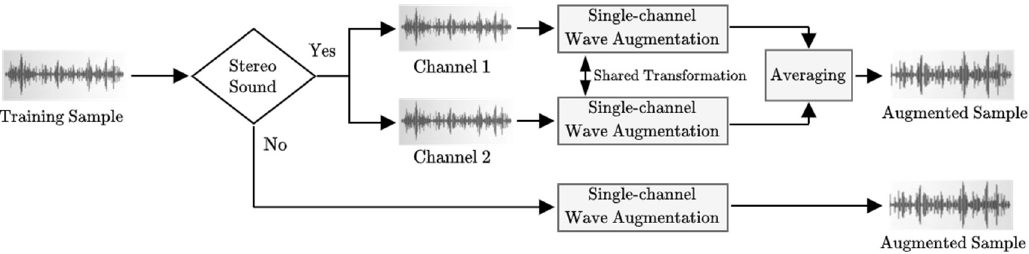
Figure 3. The procedure for the augmentation of training data.